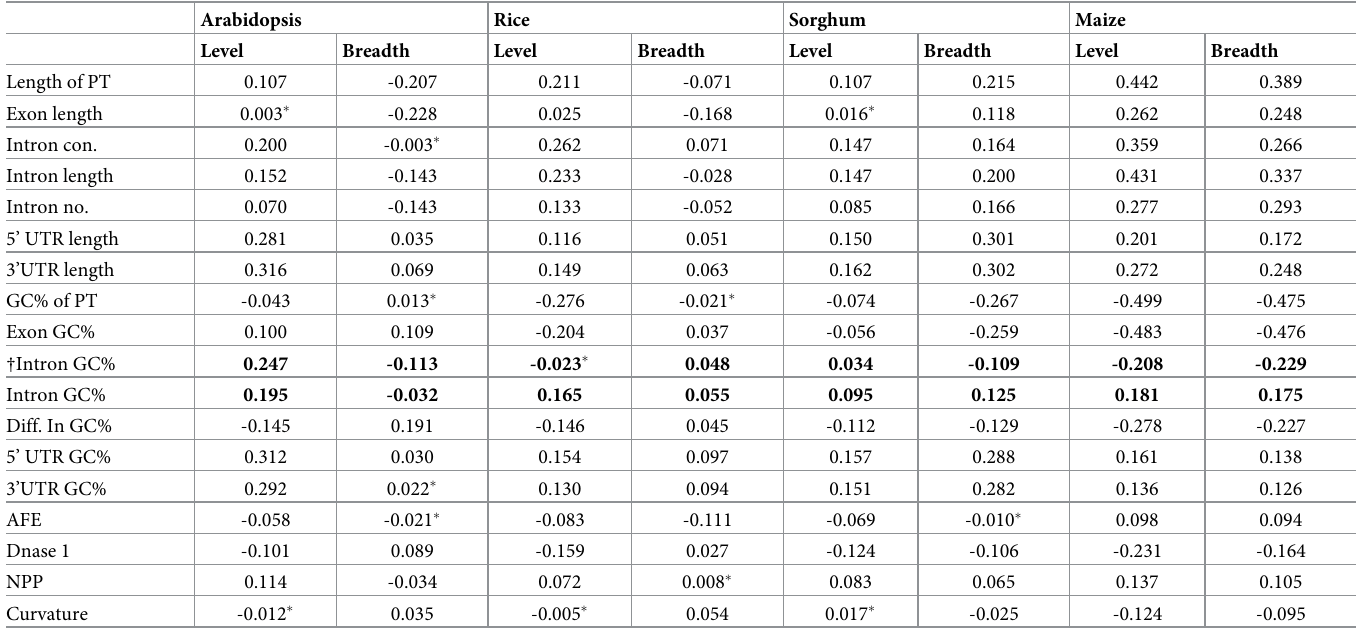
Table 2. Pearson’s correlation coefficient values for gene expression measures vs gene architecture as well as promoter properties are presented here. Arabidopsis